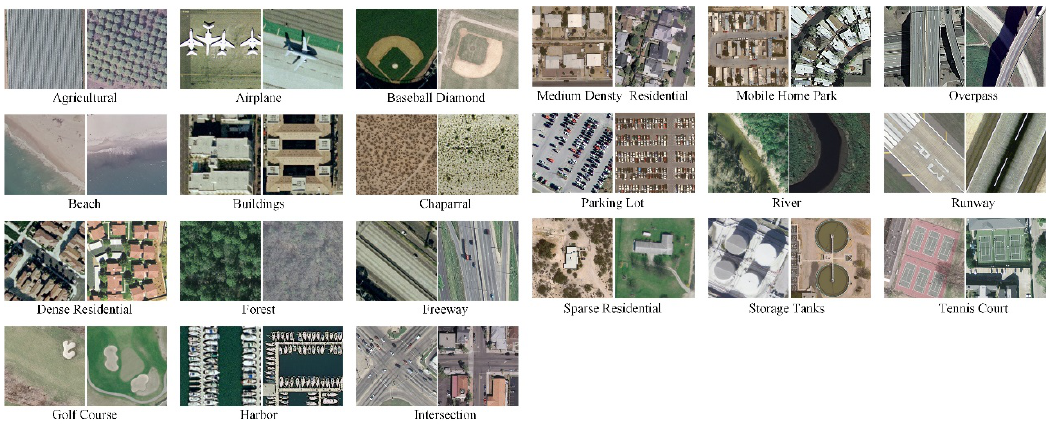
Figure 6. Two example ground truth images of each scene category in the UC Merced dataset.